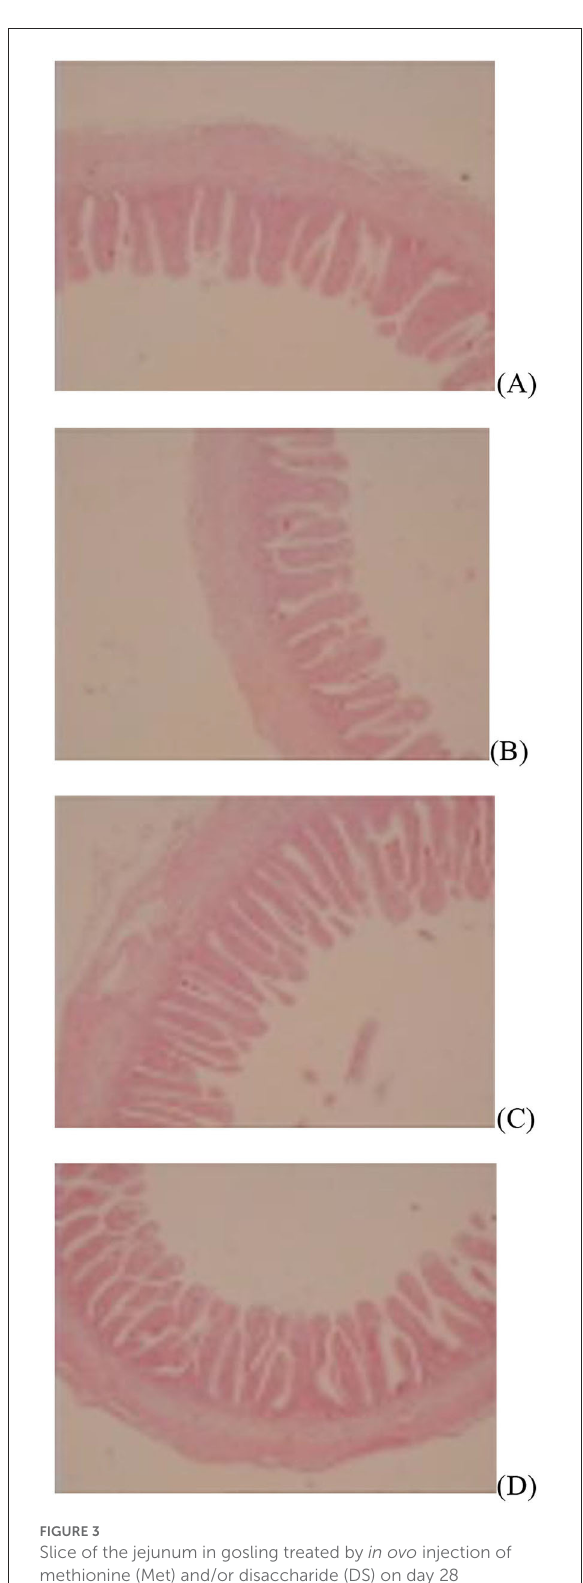
FIGURE3 Slice of the jejunum in gosling treated by in ovo injection of methionine (Met) and/or disaccharide (DS) on day 28 post-hatching. (A) Non-injection group; (B) DS injection group; (C) Met injection group and (D) DS plus Met injection